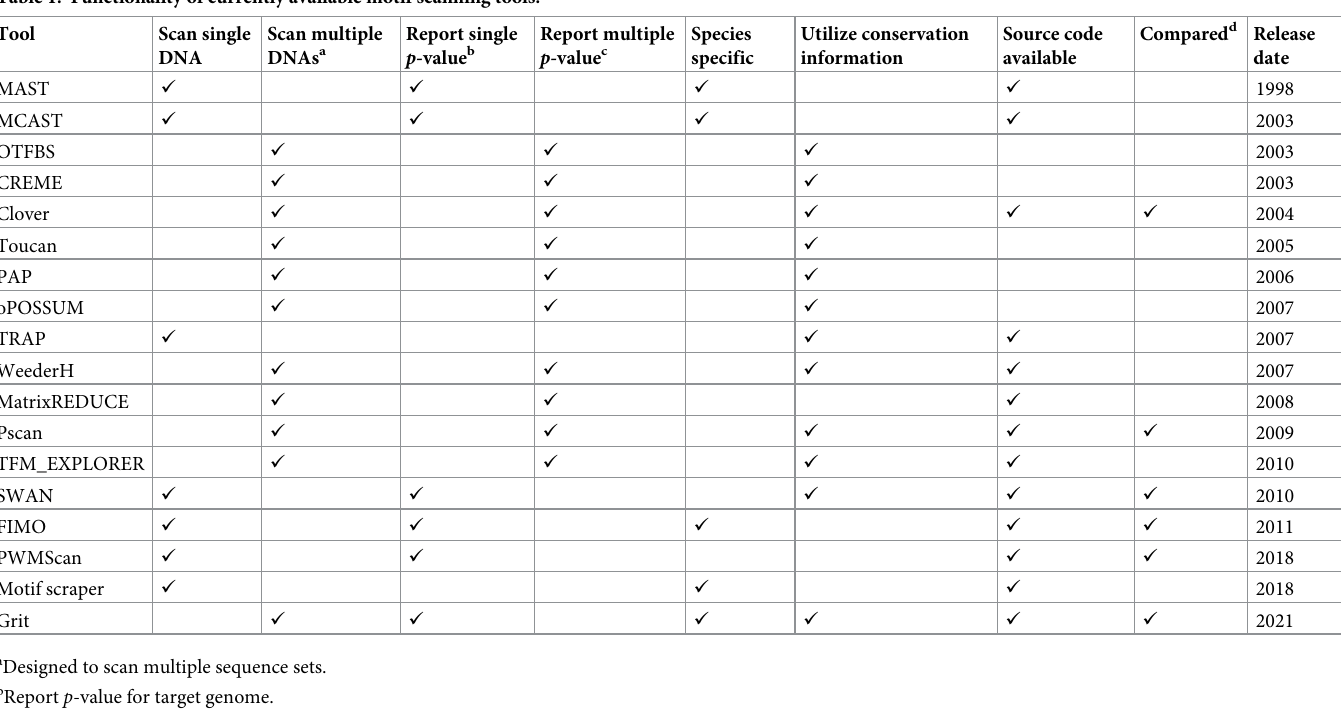
Table 1. Functionality of currently available motif scanning